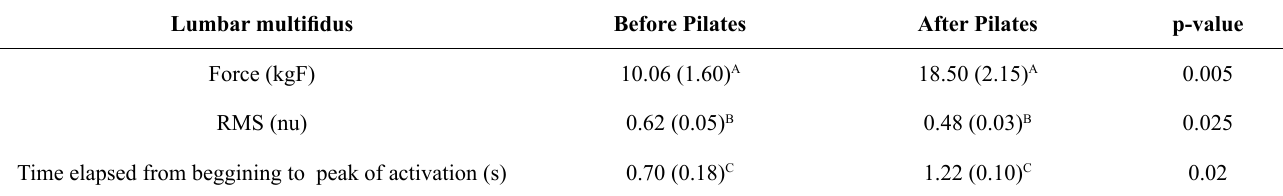
Table 2. Mean (standard error of measurement) of trunk extension force, RMS and time elapsed from beggining to peak of activation of LM.